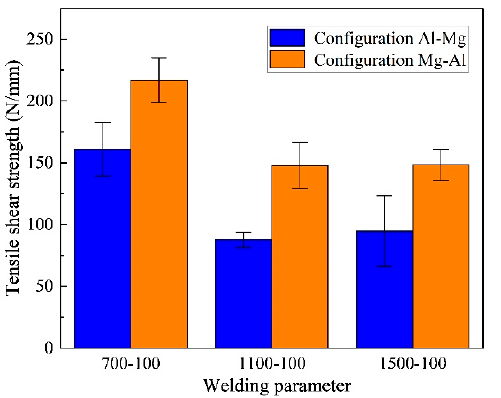
Figure 5. Tensile shear strengths of the joints formed in different lap configurations at different